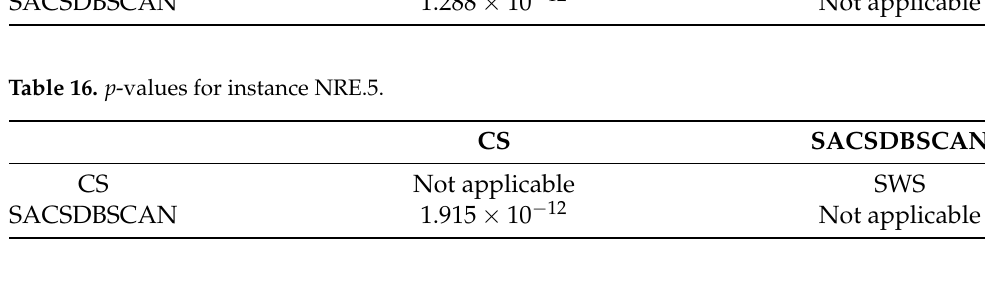
Table 17. p -values for instance NRF.5.